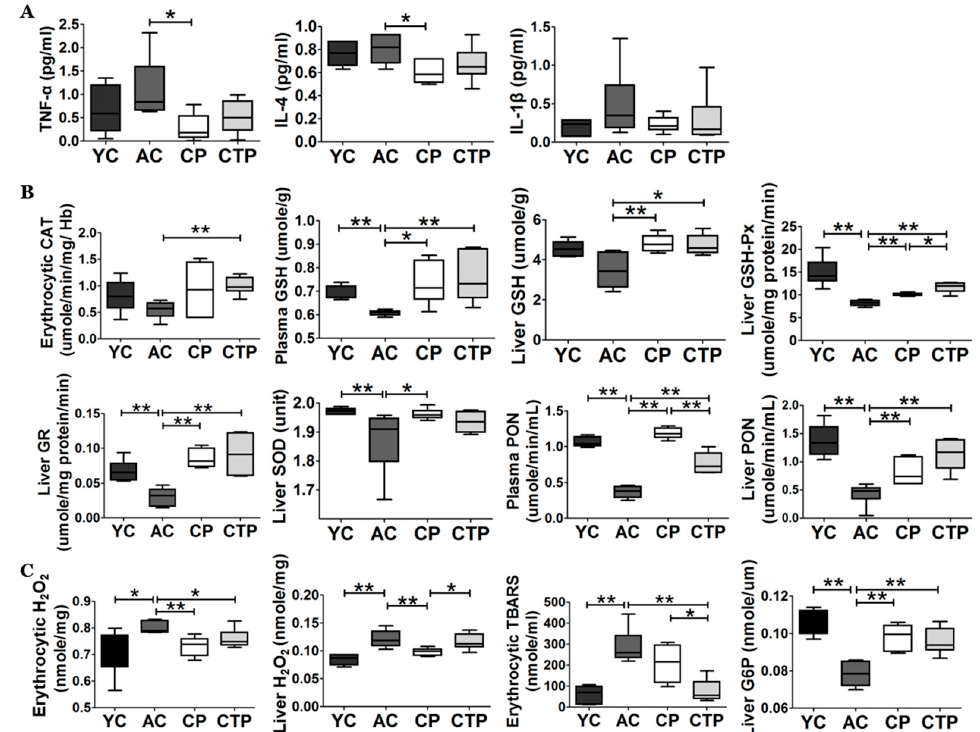
Figure 5. Effect of a 12-week supplementation of CP and CTP on plasma and liver lipid profiles, hepatic tissue morphology, and cytokine levels: ( A ) plasma lipid profiles and liver lipid profiles; ( B ) H&E and MT-stained transverse section of the liver; ( C ) H 2 O 2 and thiobarbituric acid reactive substance (TBARS) activities in erythrocytes and hepatic tissue and glucose 6 phosphatase (G6P) enzyme activity. Scale bar = 60 µm. Data are the mean ± SE. Significant differences are indicated as follows: * p < 0.05, ** p < 0.01; YC, young mice control (12 weeks old, n = 6); AC, aging control (60 weeks old, n = 6); CP, collagen peptide (60 weeks old, n = 6); CTP, collagen tripeptide (60 weeks old, n = 6).